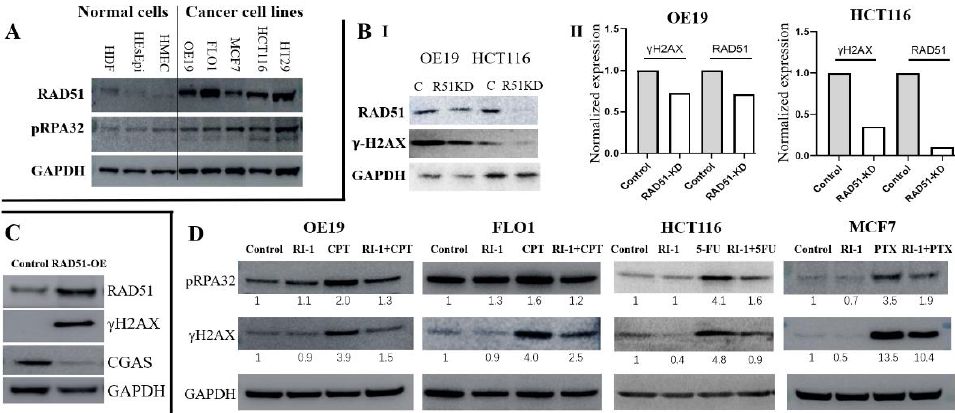
Figure 2. Elevated RAD51 contributes to spontaneous and induced DNA breaks in multiple solid tumors. ( A ) Western blot showing expression of RAD51 and phosphorylated-RPA32 (a marker of DNA end resection, a decisive step in HR) in normal cell types (HDF, human diploid fibroblasts; HEsEpi, human esophageal epithelial cells; HMEC, human mammary epithelial cells) and human cancer cell lines—esophageal adenocarcinoma (OE19, FLO-1), breast cancer (MCF7) and colon cancer (HCT116, HT29). ( B ) Rad51 was suppressed in cancer cell lines (OE19, HCT116) using shRNA and cells selected in puromycin. (I) Western blot shows the expression of RAD51 and γ -H2AX (a marker of DNA breaks) in control (C) and RAD51-knockdown (R51KD) cells; (II) Bar graphs show expression of γ -H2AX and RAD51 normalized to GAPDH; ( C ) Western blot shows the expression of RAD51, γ -H2AX (a marker of DNA breaks) and CGAS in control and RAD51-overexpressing (RAD51-OE) breast cancer (MDA231) cells; ( D ) Western blot showing expression of phosphorylated- RPA32 and γ -H2AX in different cancer cell lines treated with DMSO (control), RAD51 inhibitor (RI- 1; 20 μM) alone or in the presence of DNA breaking agents— camptothecin (CPT; 100 nM), paclitaxel (PTX; 50 nM) or 5- fluorouracil (5FU; 5 μM) for 48 h .